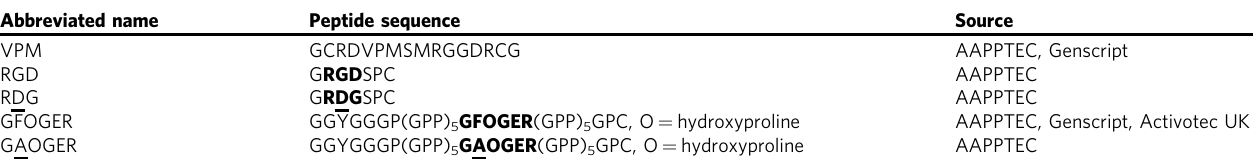
Table 1 Peptide hydrogel